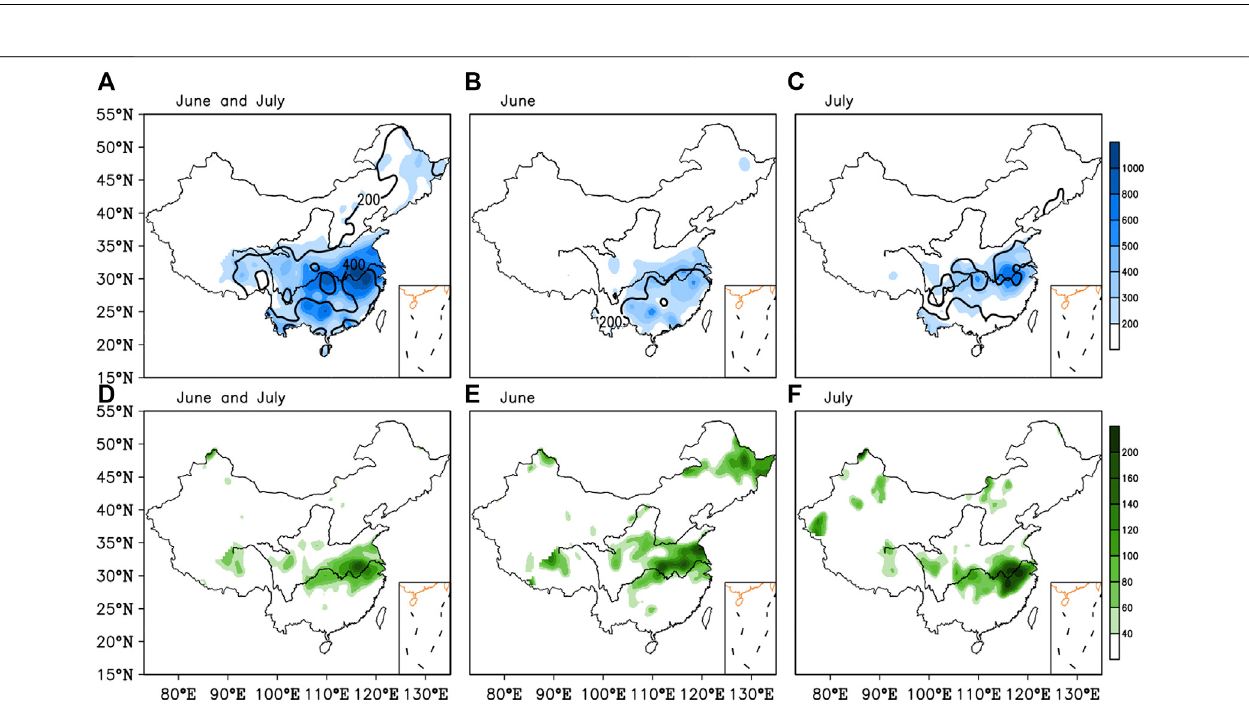
FIGURE2| Accumulatedprecipitation(shadedin A – C ,unit:mm)andanomalypercentage ofprecipitation(shadedin D – E ,unit: %)inJune – July (A,D) ,June (B,E) , andJuly (C,F) in2020over2,417stationsofChina.Contoursin A – C areclimatologicalmeanprecipitationofmorethan200 mmwithintervalsof200 mm.Climatologyof precipitation is calculated from 1981 to